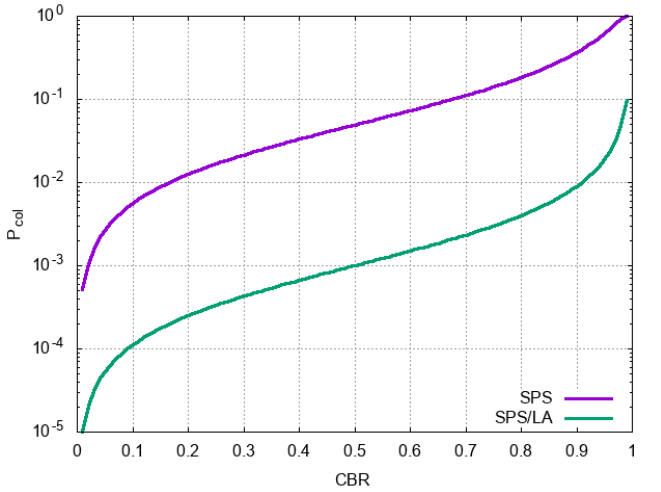
Figure 6. Collision probabilities upon reselection under SPS and SPS/LA.